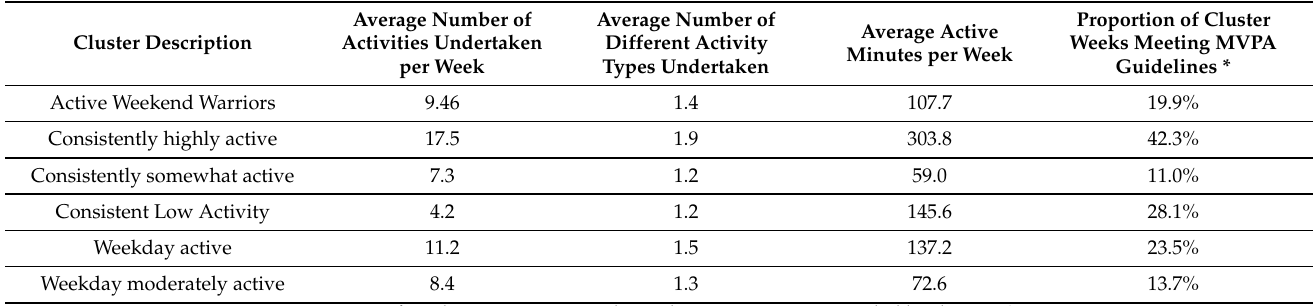
Table 5. Physical activity characteristics of weekly physical activity behaviour clusters.